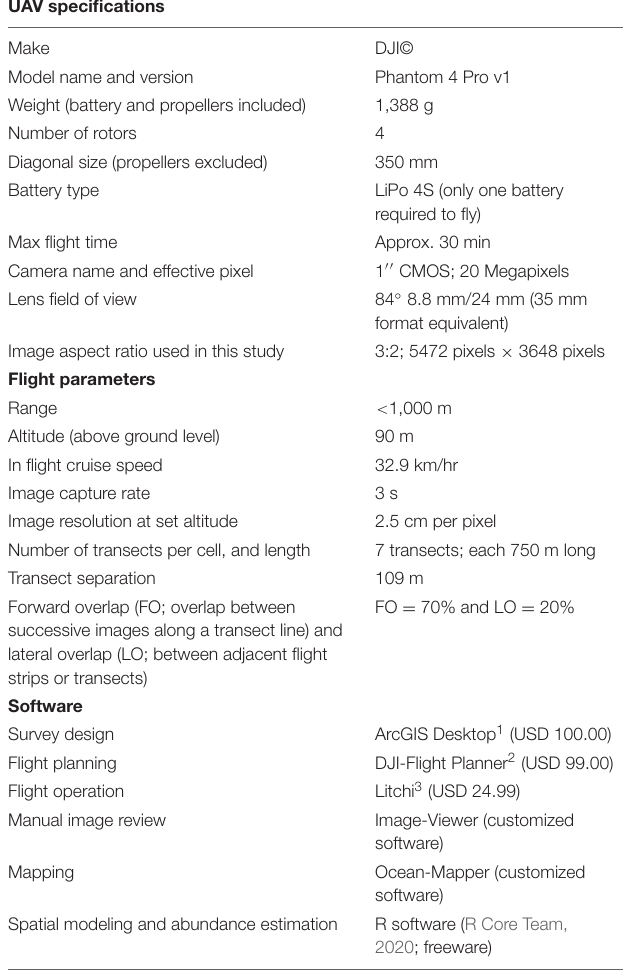
TABLE 1 | Drone and software specifications, and flight